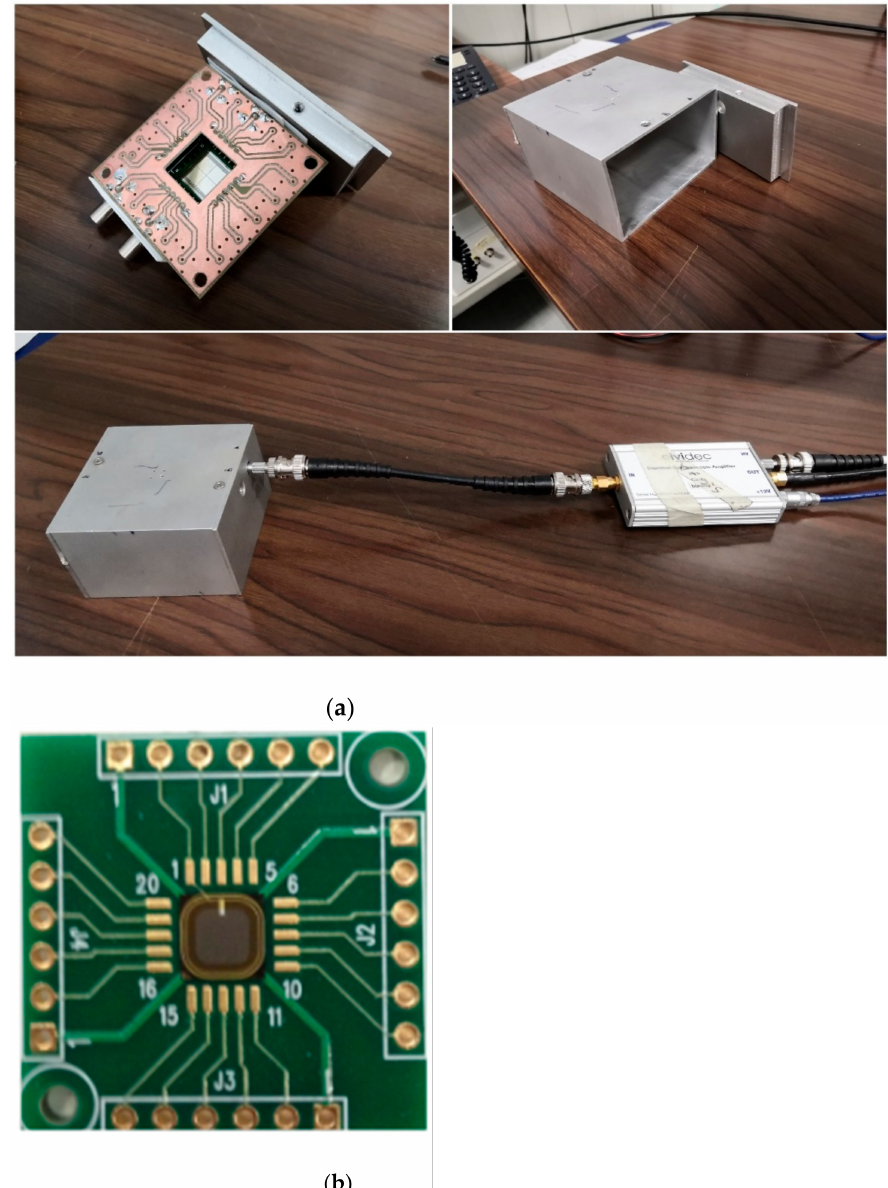
Figure 1. ( a ) The 100 µ m silicon carbide detector used in this paper. The four independent pixels and the chip electronics are visible in the center of the top-left figure. The aluminum casing in which it was contained is shown in the top right. The detector assembled and connected to the spectroscopic preamplifier is shown in the bottom figure. ( b ) The chip and the single active volume of the 10 µ m silicon carbide detector used in this